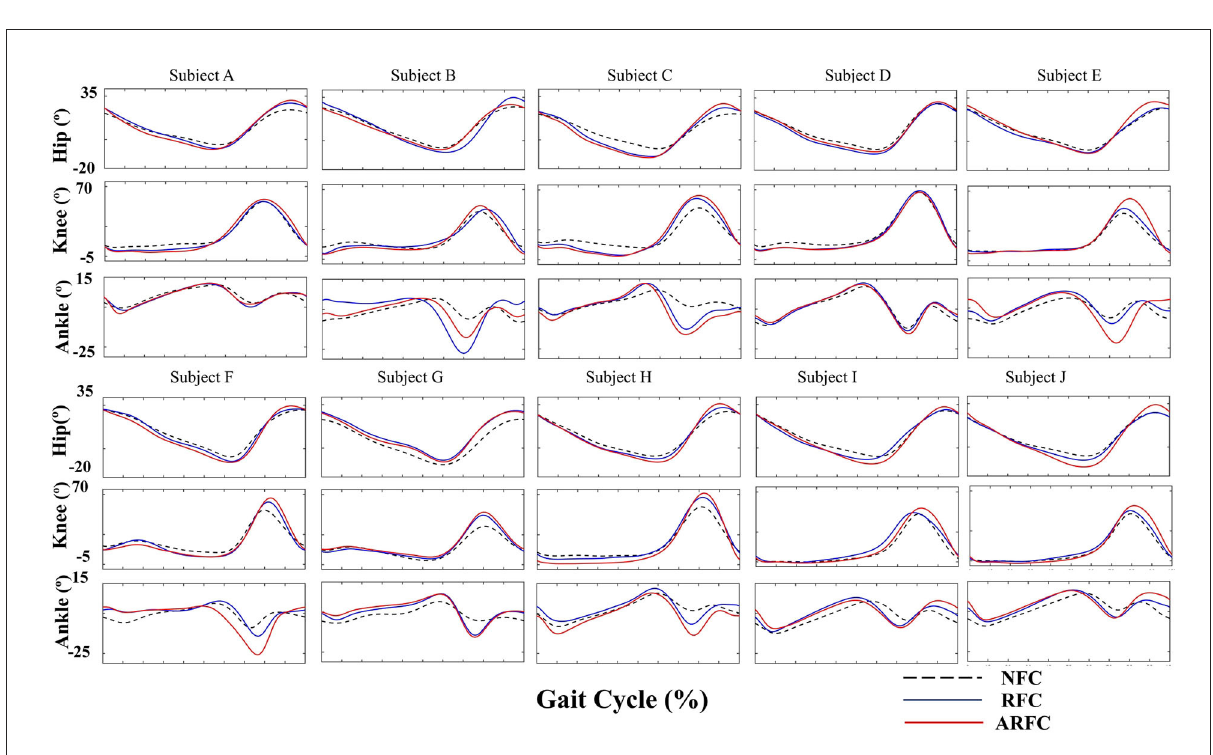
FIGURE7 Joint kinematics of the hip, knee, and ankle joints under three different stimulation conditions for individual participants.